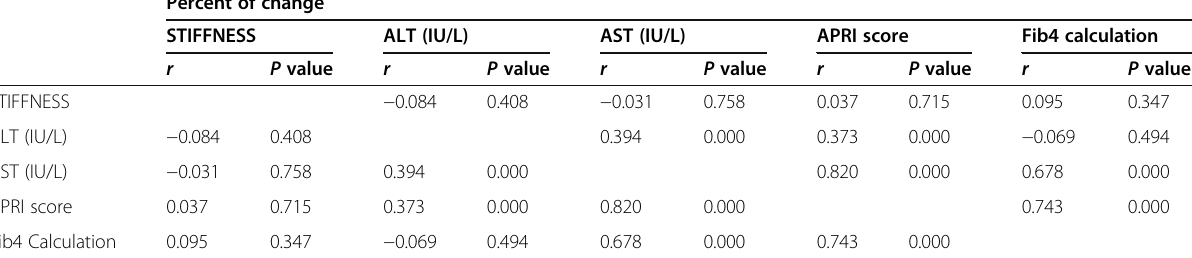
Table 5 Correlation between the percentage of change of liver enzymes and fibrosis scores Percent of change